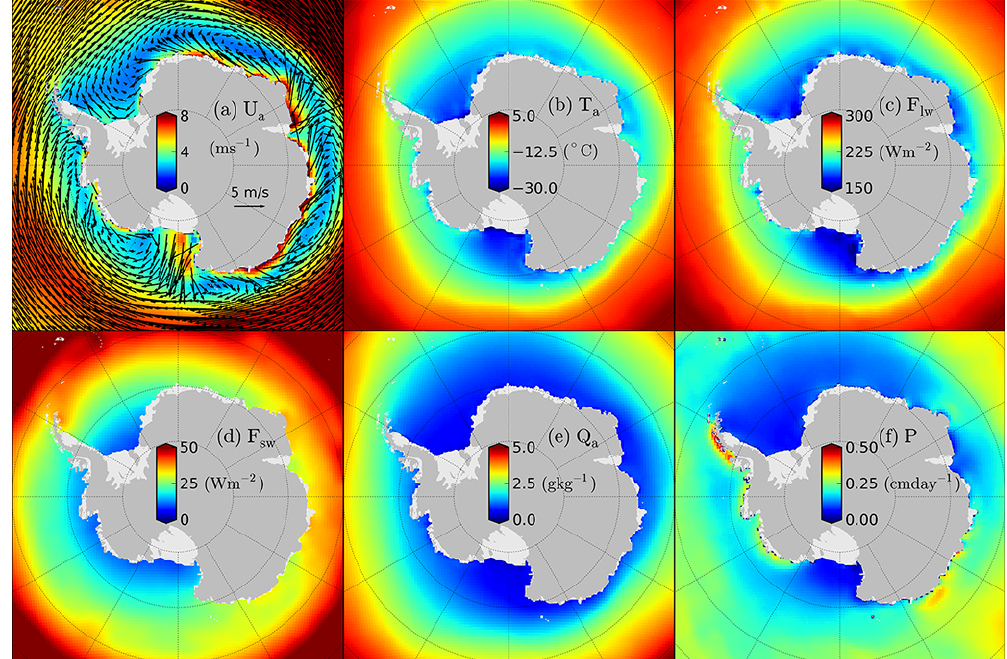
Fig. 2. Mean (1980–2011) ERA-Interim (Dee et al., 2011) winter (July–September, JAS) atmospheric forcing. (a) 10m wind speed, overlain with 10m wind vectors (every third grid point), (b) 2m air temperature, (c) incoming long-wave radiation, (d) incoming short-wave radiation, (e) 2m specific humidity, (f) total precipitation (snow and